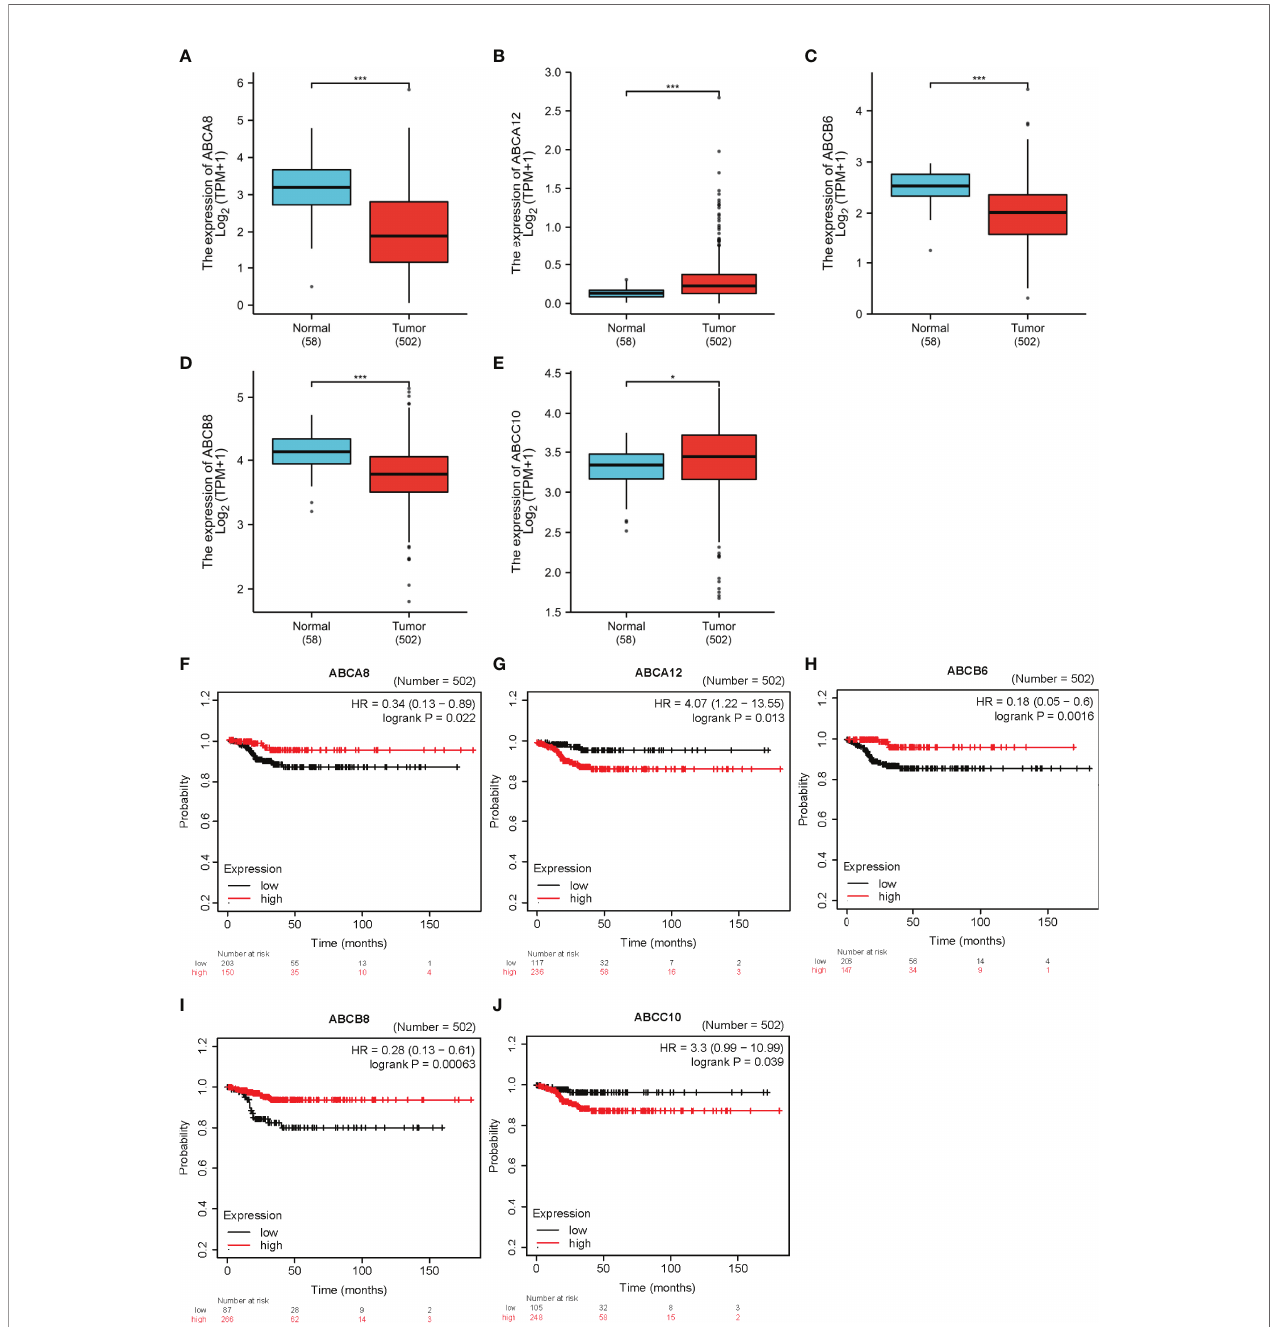
FIGURE 1 | The expression levels and prognostic values of fi ve hallmark ABC transporters in TC. (A – E) ABCA8 , ABCB6 , and ABCB8 mRNA expression was downregulated in TC compared with that in normal tissues, while that of ABCA12 and ABCC10 was upregulated. (F – J) Correlation between expression of the fi ve hallmark ABC transporters and prognoses for TC. * P < 0.05, *** P <